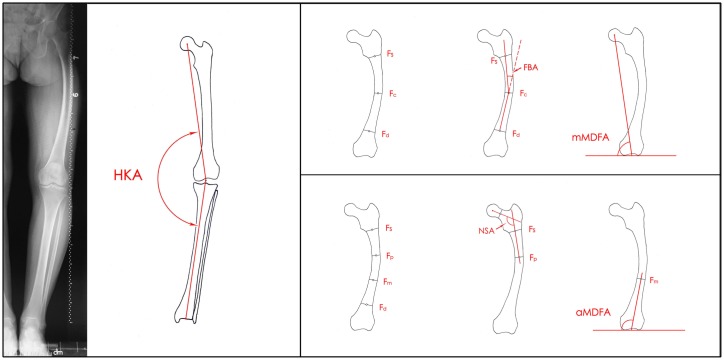
Radiographic measurements.HKA: hip-knee-ankle angle; Fs: a point bisecting the width of the femoral shaft at the lower junction of the lesser trochanter and the shaft; Fd: a point bisecting the width of the shaft 10 cm proximal to the knee joint; Fp: a point bisecting the width of the shaft at junction of the proximal third and the midsection; Fm: a point bisecting the width of the shaft at junction of the midsection and the distal third; Fc: a point bisecting the width of the femoral shaft midway between Fs and Fd; NSA: neck-shaft angle; FBA: femoral bowing angle; mMDFA: mechanical medial distal femoral angle; aMDFA: anatomic medial distal femoral angle.